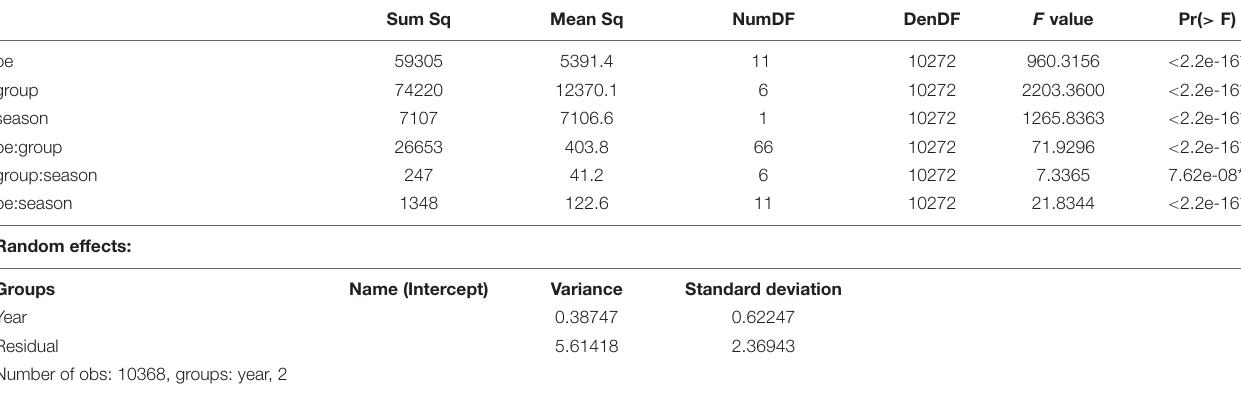
FIGURE 4 | Lesion diameters at 4 dpi upon inoculation of 12 different B. elliptica isolates on leaves of 18 different lily genotypes. Lesion diameters measured in mm are plotted for each single isolate in 12 separate panels. Each of the colored boxes represents all lesion diameters measured for a given lily hybrid group in all four repetitions of the disease assays. TABLE 3 | ANOVA results of the interaction in leaves between 18 Lilium genotypes and 12 B. elliptica isolates measured as lesion